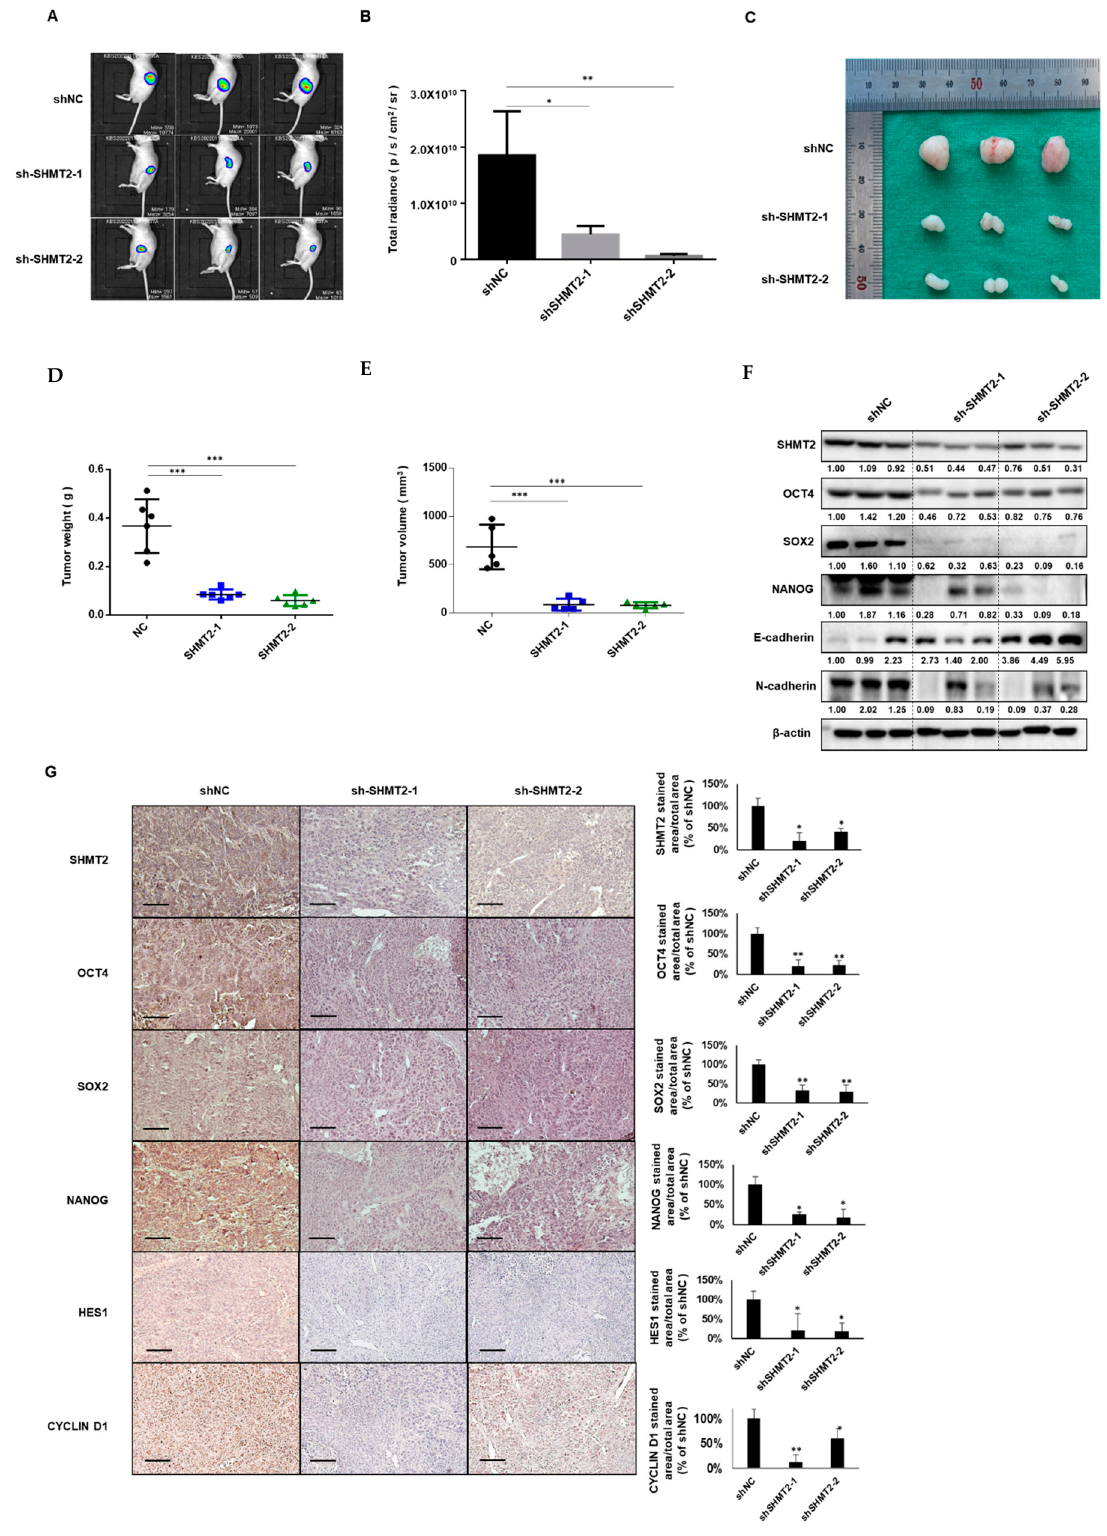
Figure 6. Tumor growth in a mouse xenograft model after SHMT2 knockdown. 2 × 10 6 control- transfected Luciferase-expressing FADU (FADU-Luc) cells (shNC) and shRNA-transfected FADU- Luc cells (shSHMT2-1 and sh SHMT2 -2) were subcutaneously injected into 15 BALB/c-nude mice. ( A , B ) Representative final tumor images of cancer cells tracked with the in vivo imaging system following the injection of mice with FADU-Luc cells. ( C – E ) Images of tumors at the experimental endpoint. The tumors weight and volume were measured at the time of sacrifice. ( F ) Western blots